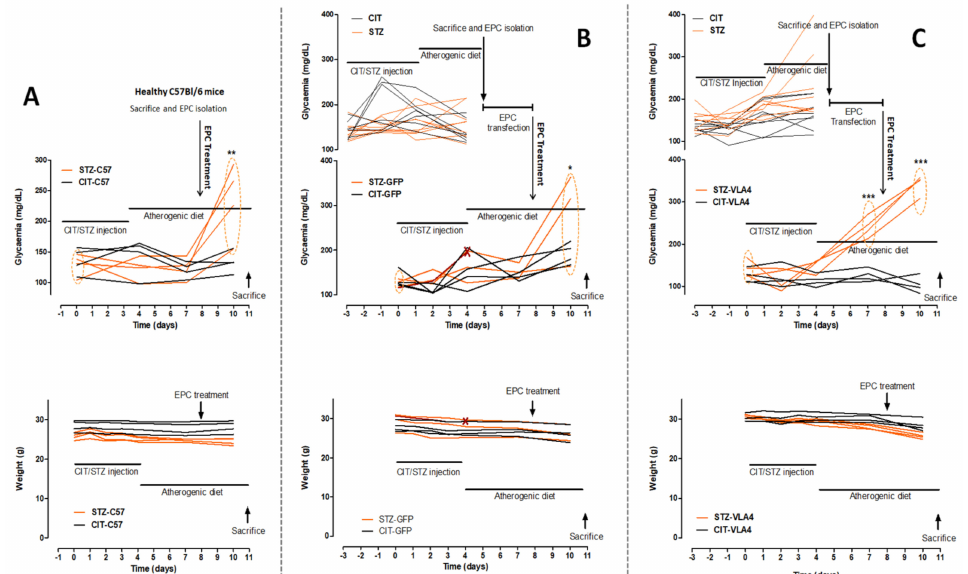
Figure 1. ( A ) Glycaemia (upper graph) and body weights (lower graph) of CIT/STZ mice treated with unmodified EPCs from healthy C57BL; ( B ) Glycaemia (upper graph) and body weights (lower graph) of CIT/STZ mice treated with GFP-transfected EPCs; ( C ) Glycaemia (upper graph) and body weights (lower graph) of CIT/STZ mice treated with EPCs transfected to overexpress α 4 and β 1 integrins. A moderate decrease in body weight can be observed for the diabetic dyslipidemic mice and one dyslipidemic mouse starting before the EPC injection, as induced by a more robust response to STZ, with significantly increased glycemic levels before EPC treatment. For the ( B , C ) experimental arms, the uppermost diagram represents the glycaemia of mice used to obtain EPCs for transfection. Traces from diabetic dyslipidemic animals (STZ mice) are shown in orange and those from dyslipidemic non-diabetic mice (CIT mice), are in black. * p < 0.05, ** p < 0.01, *** p < 0.001 compared with day 0